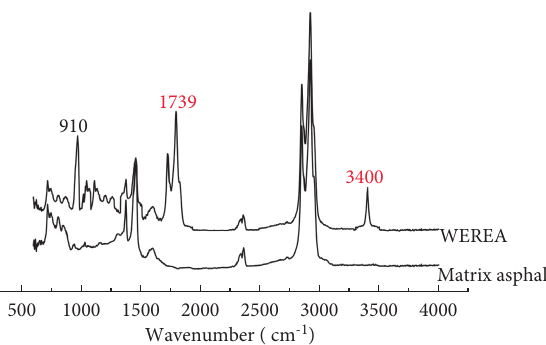
Figure 15: FTIR spectrum for WEA and asphalt